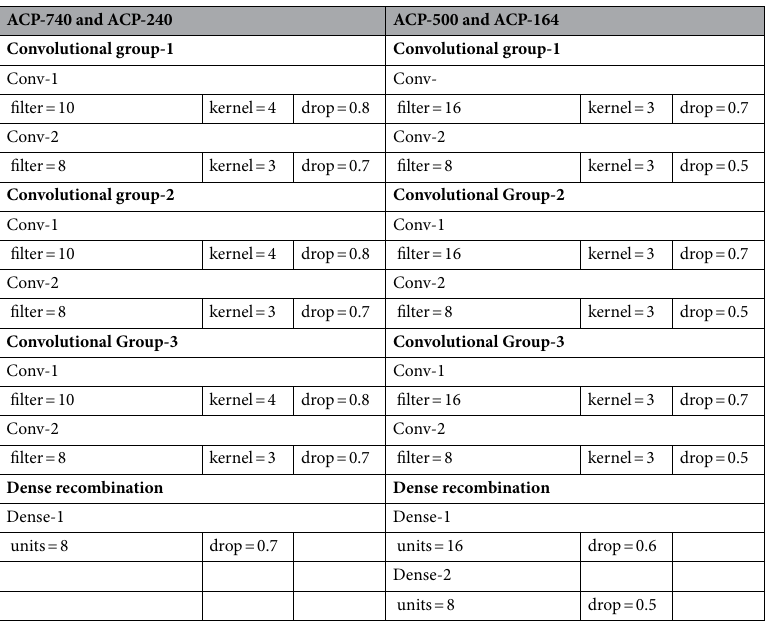
Table 2. Hyperparameter configurations employed for different ACP datasets. In this table, ‘Conv’ = a convolutional layer, ‘Dense’ = a fully connected layer, ‘filter’ = number of filters in a convolutional layer, ‘kernel’ = size of filters in a convolutional layer, ‘drop’ = dropout rate, and ‘units’ = number of neurons in a fully connected